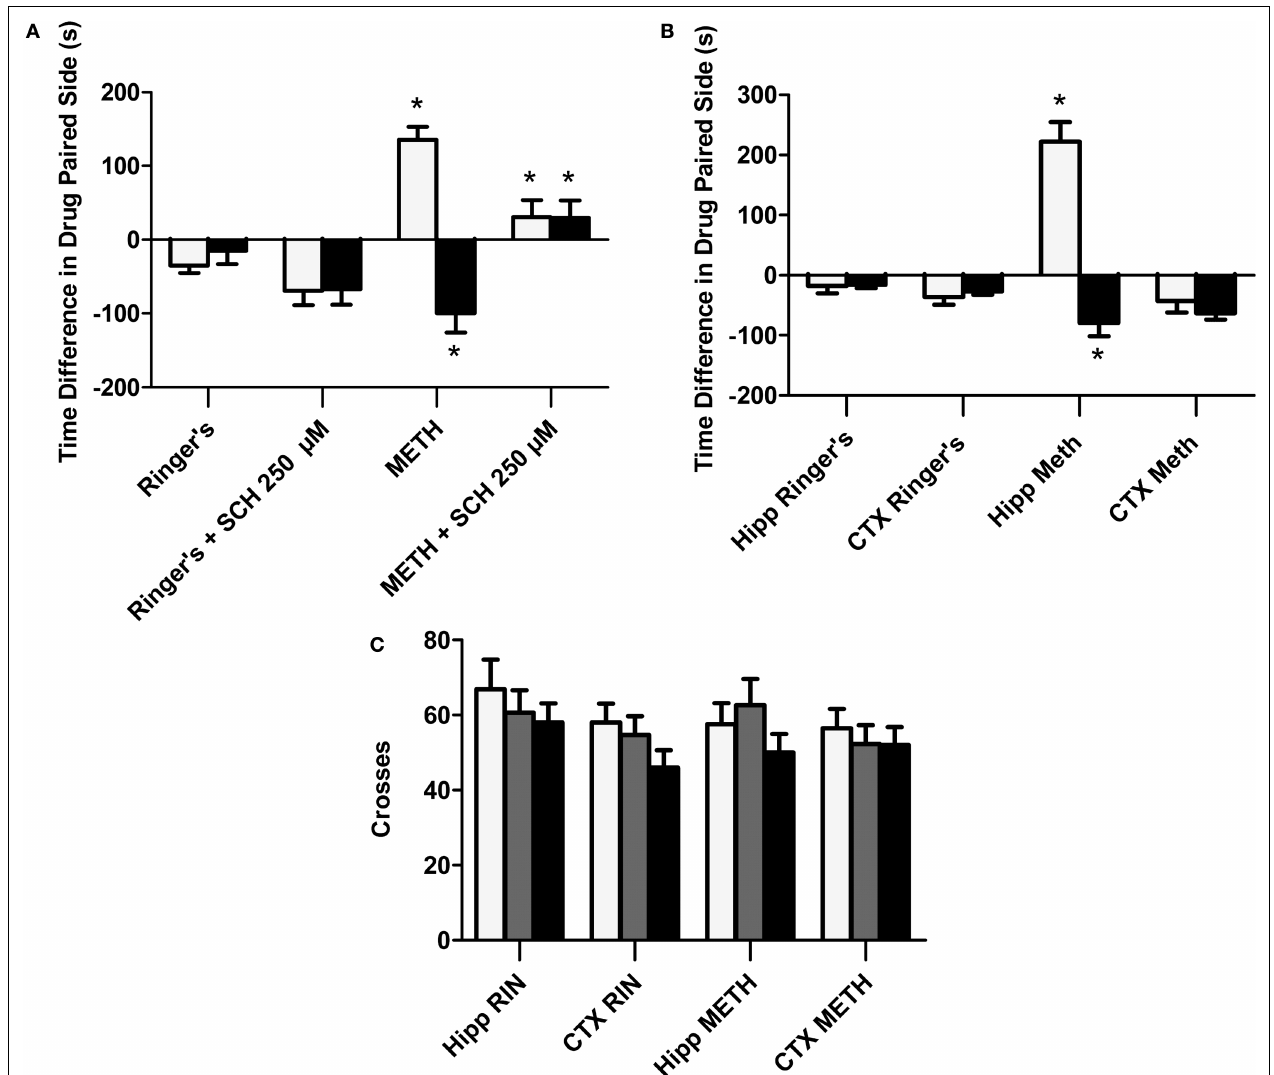
FIGURE 2 | Role of local D /D receptors in the acquisition and expression 1 5 of intrahippocampal METH CPP. (A) The effects of intrahippocampal METH µg/µl ( n = 6) or Ringer’s ( n = 5) on CPP Test 1 and the effects of local SCH 23390 on CPP acquisition (Test 1) and CPP expression (Test 2) of intrahippocampal METH CPP ( n = 6) or Ringer’s vehicle ( n = 6). (B) METH only induces CPP in the hippocampus and not the cortex (CTX). The effects of intracranial METH (hippocampus n = 13 or CTX n = 10) or Ringer’s